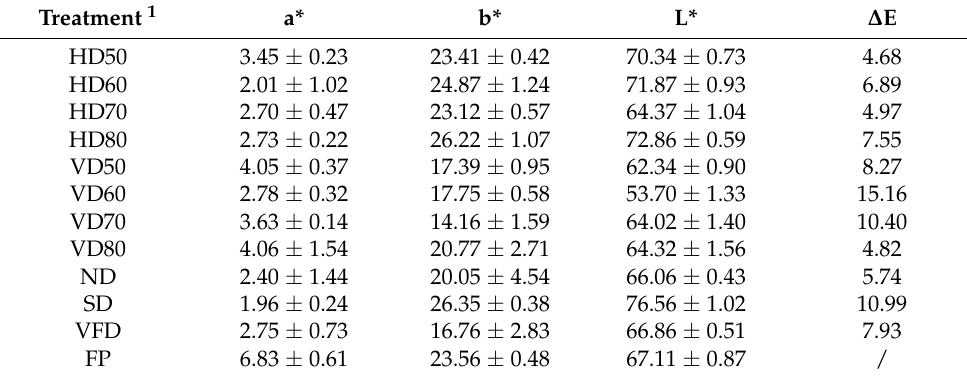
Table 1. Effects of drying methods on Chroma value of dried burdock root.